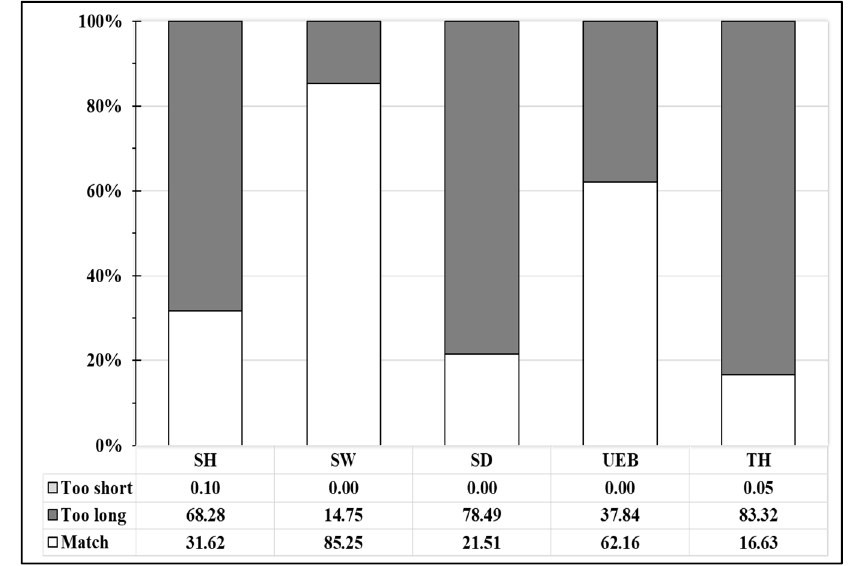
Figure 5. Mismatch rate of design specifications of the present submarine